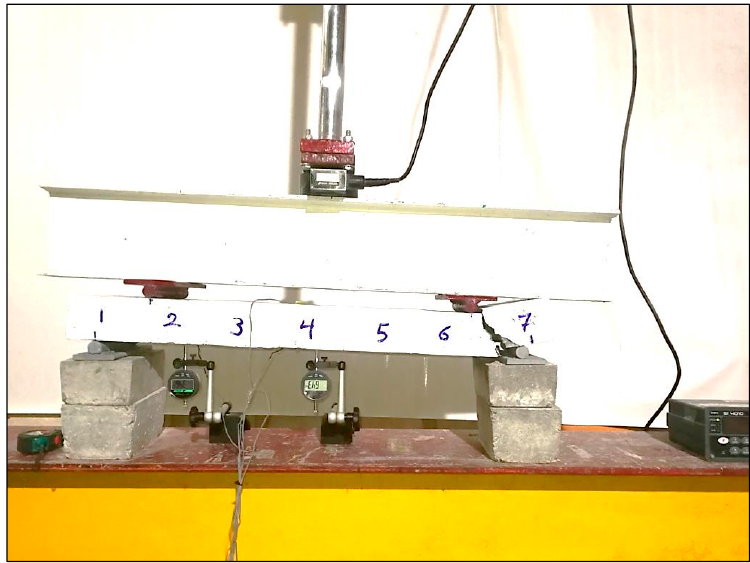
Figure 8. The failure mode of beam SB1-CM-1A.